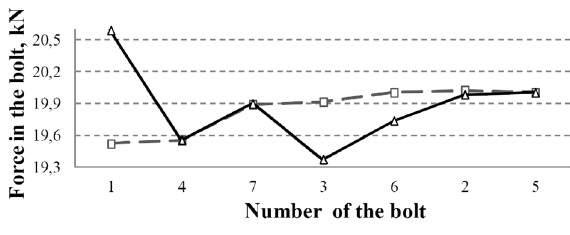
Fig. 6. Preload values at the end of the assembly process